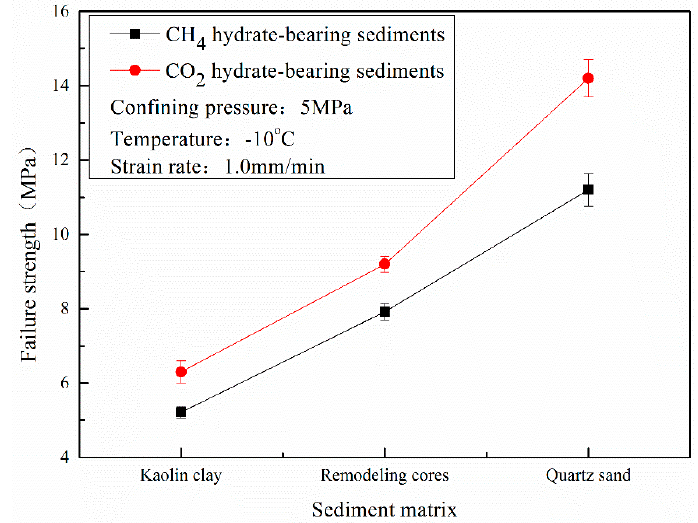
Figure 13. Failure strength of the CH 4 and CO 2 hydrate-bearing sediments in different sediment matrices.